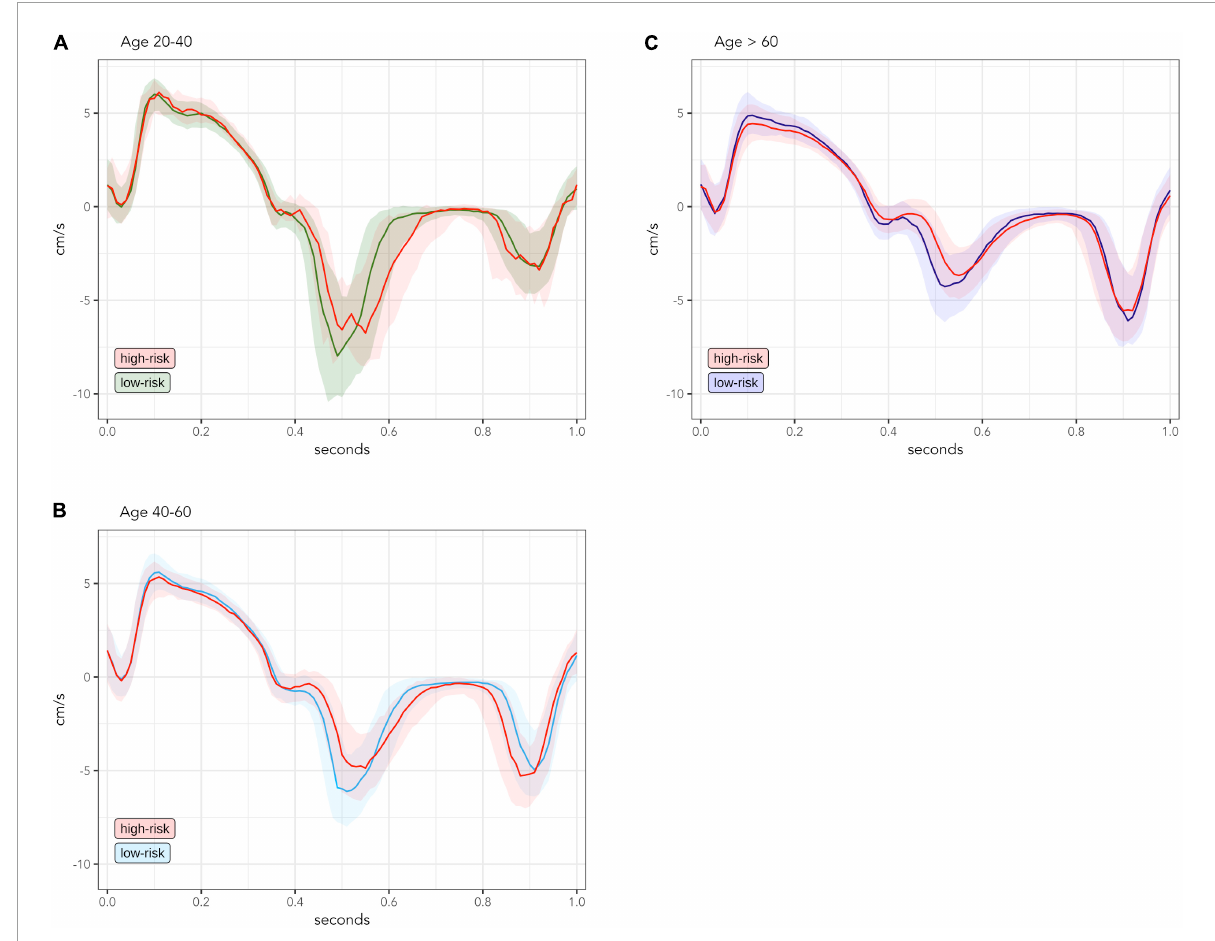
FIGURE2 Comparison of median and interquartile range of measured TDI-values between low-risk and high-risk groups, divided into age groups of 20–40-year-olds [ (A) ; low-risk n = 226; high-risk n = 22], 40–60-year-olds [ (B) ; low-risk n = 432; high-risk n = 216] and > 60 year-olds [ (C) ; low-risk n = 223; high-risk n = 644]. TDI values are averaged for septal and lateral mitral sites, presented for one standardized heart cycle of 1 s. Solid lines are median values. Transparent colored areas represent interquartile